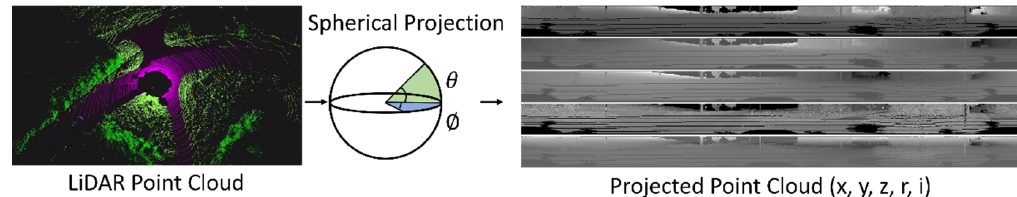
Figure 2. Point cloud spherical projection.